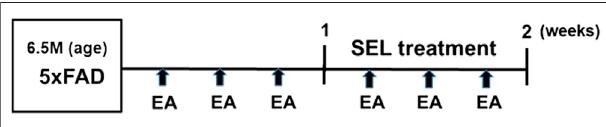
FIGURE 1 | Experimental timeline. SEL, selegiline; EA,